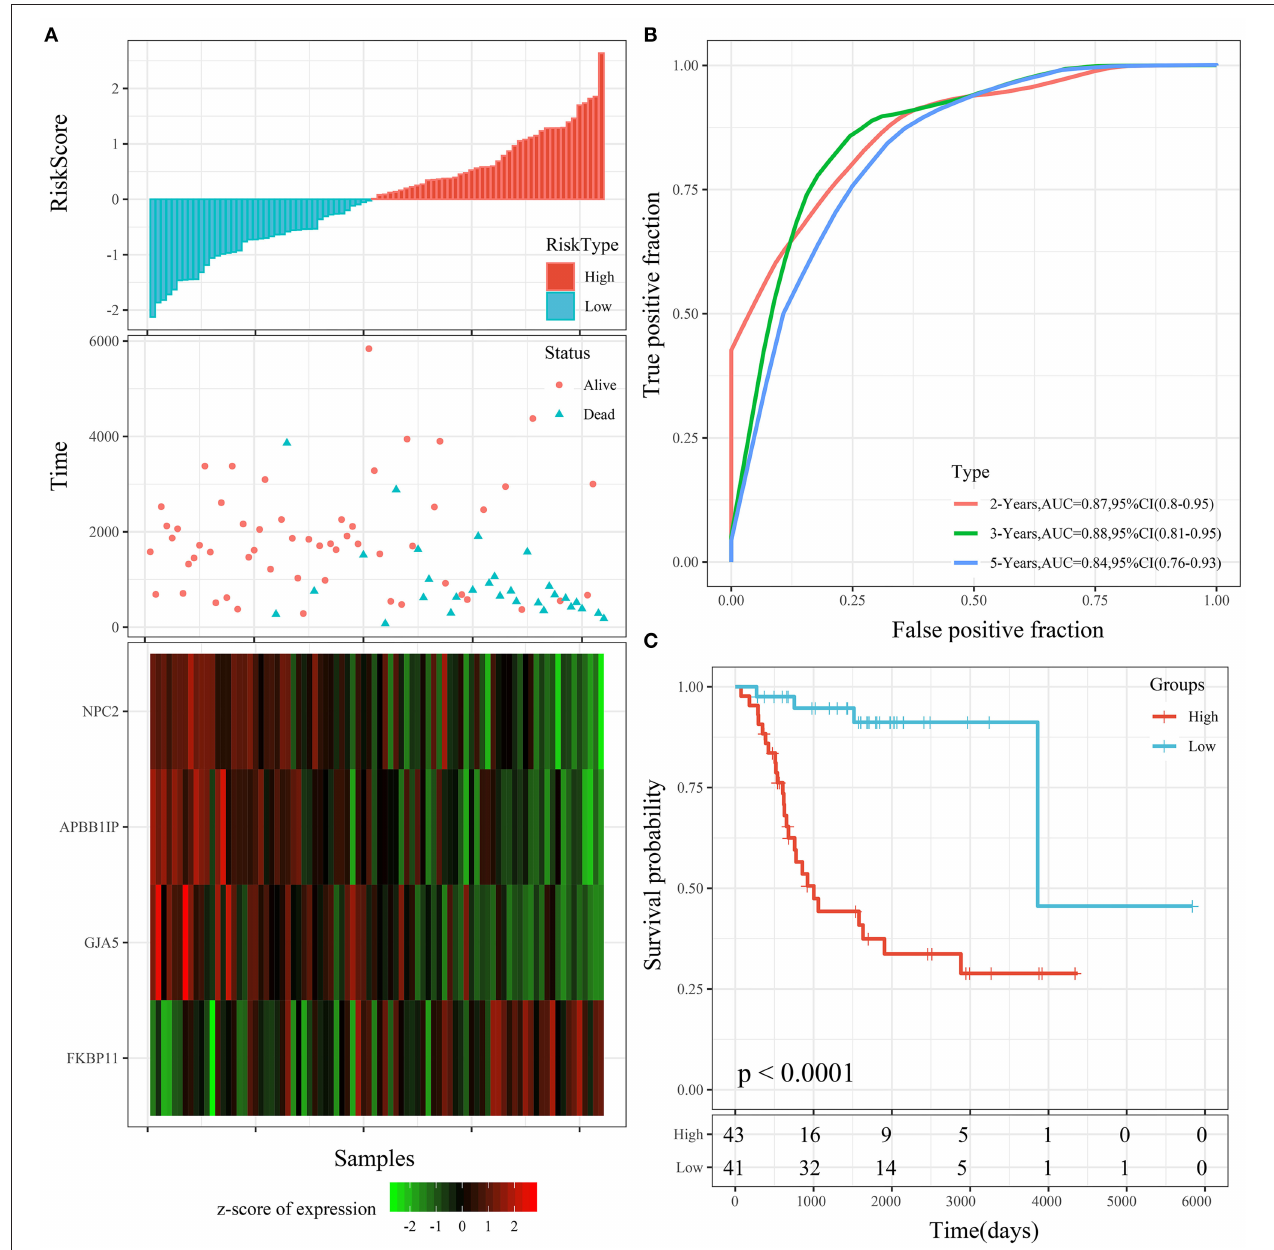
FIGURE 8 | (A) Risk score, survival time, survival status, and 4-gene expression in the entire TARGET cohort. (B) ROC curve and AUC of the 4-gene signature. (C) KM survival curve distribution of the 4-gene signature in the entire TARGET cohort.